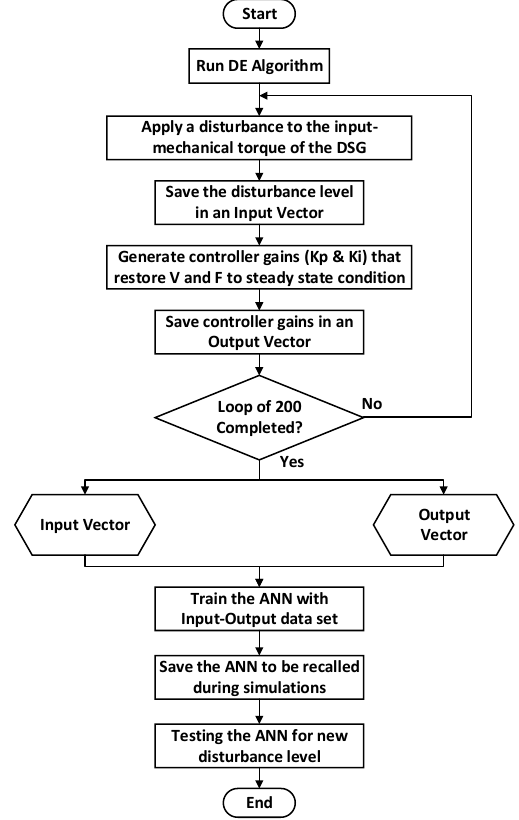
Figure 9. Flowchart of the proposed approach.